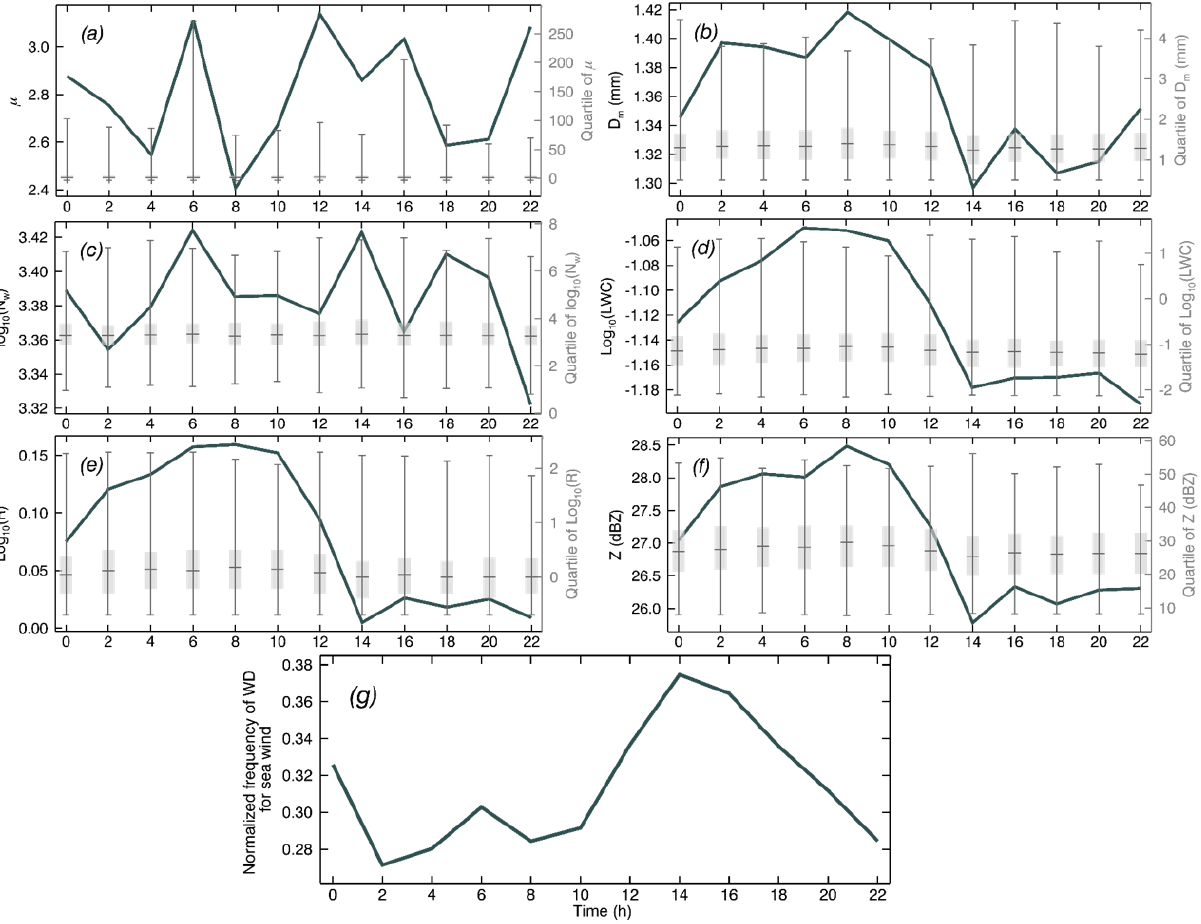
Figure 8. Two-hour interval time series of (a) µ , (b) D m , (c) log 10 (N w ) , (d) log 10 (R) , (e) log 10 ( LWC ) , (f) Z h , and (g) normalized frequency of wind direction for sea wind (45 to 225 ◦ ) with quartiles for the total period. Solid lines are quartiles for each time.